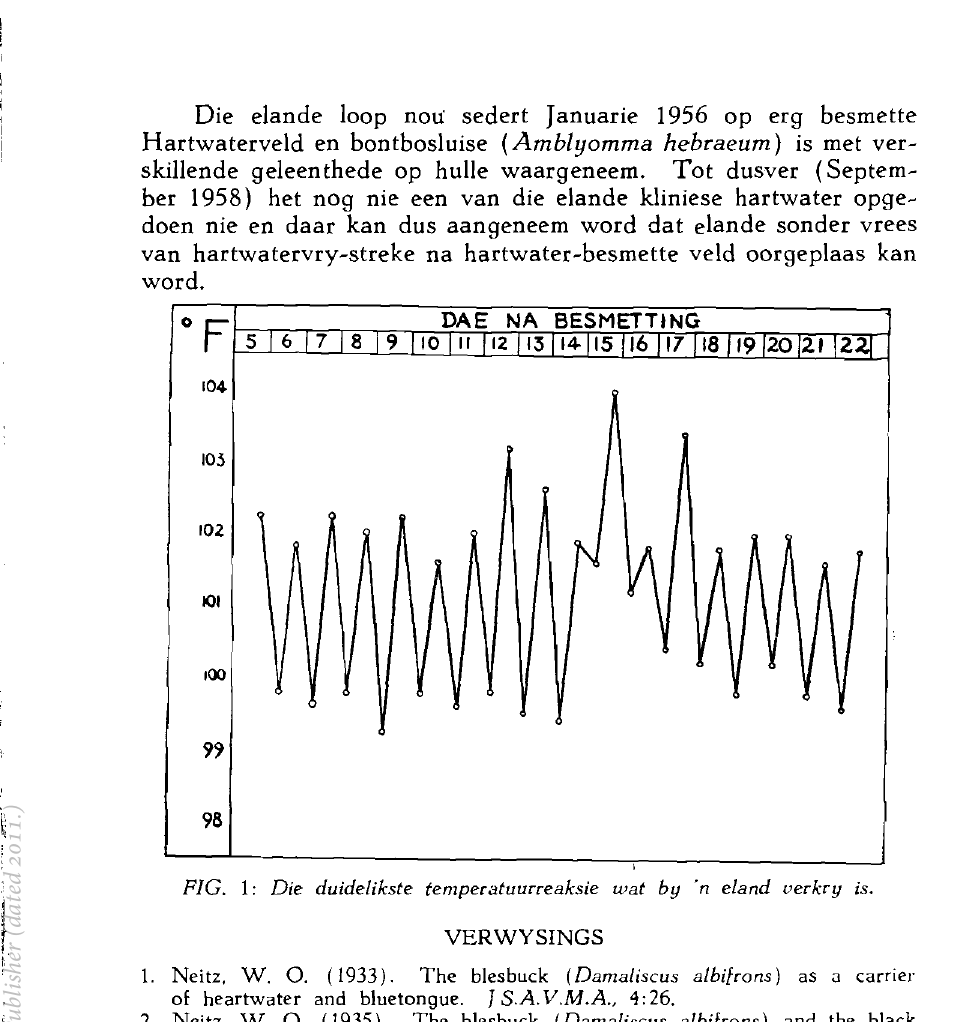
1. Neitz, W. O. (1933).